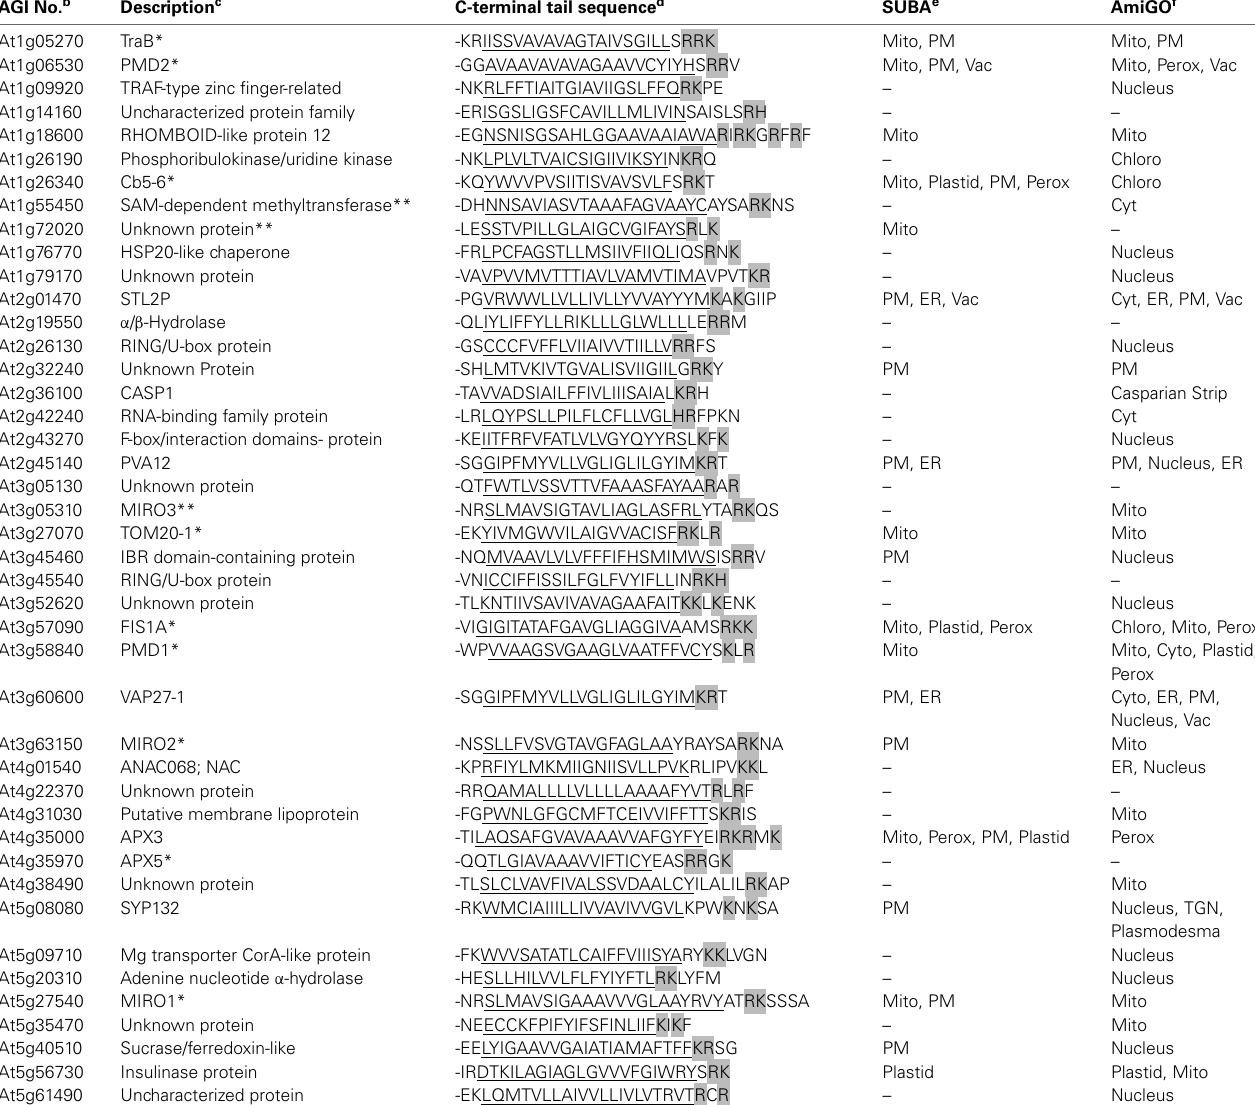
Table 2 | Candidate Arabidopsis TA proteins containing a putative OMM dibasic targeting signal motif a . AGI No.